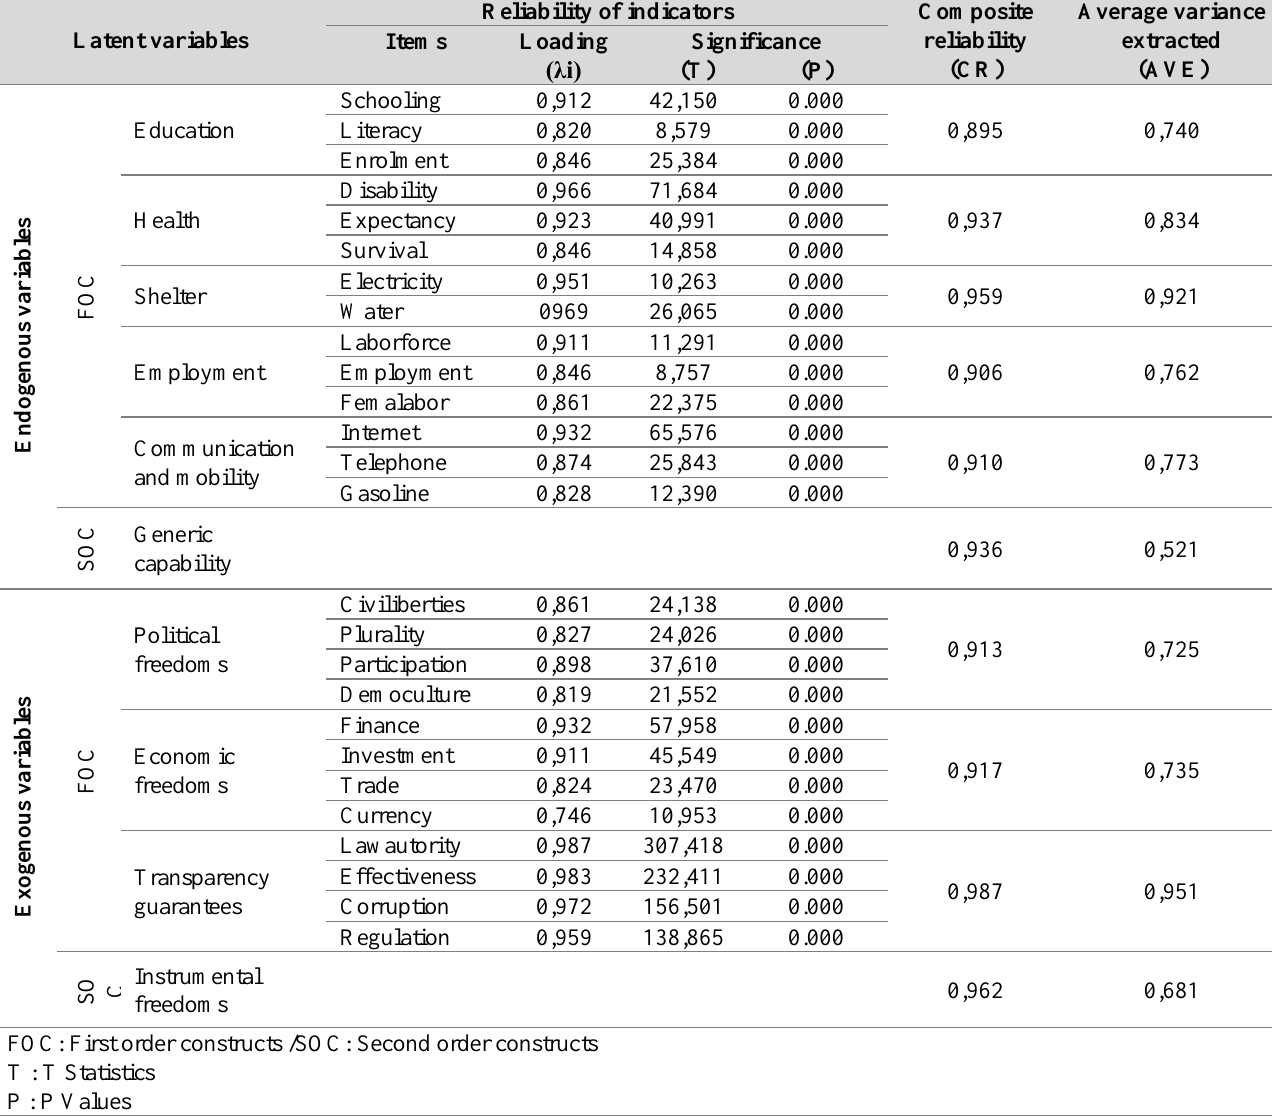
Reliability of indicators and validity of